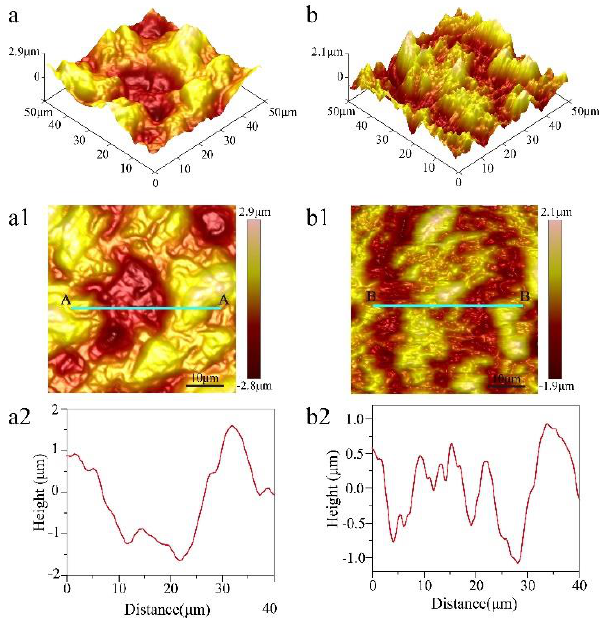
Figure 4. Atomic force microscope (AFM) image surface morphology of titanium machined only by EDM. ( a ) 3D height map, ( a1 ) surface height map, and ( a2 ) height profile through section A–A for scanned location ( a1 ), and machined by EDM and ECE time 20 s. ( b ) 3D height map, ( b1 ) surface height map, and ( b2 ) height profile through section B–B for the scanned location ( b1 ).